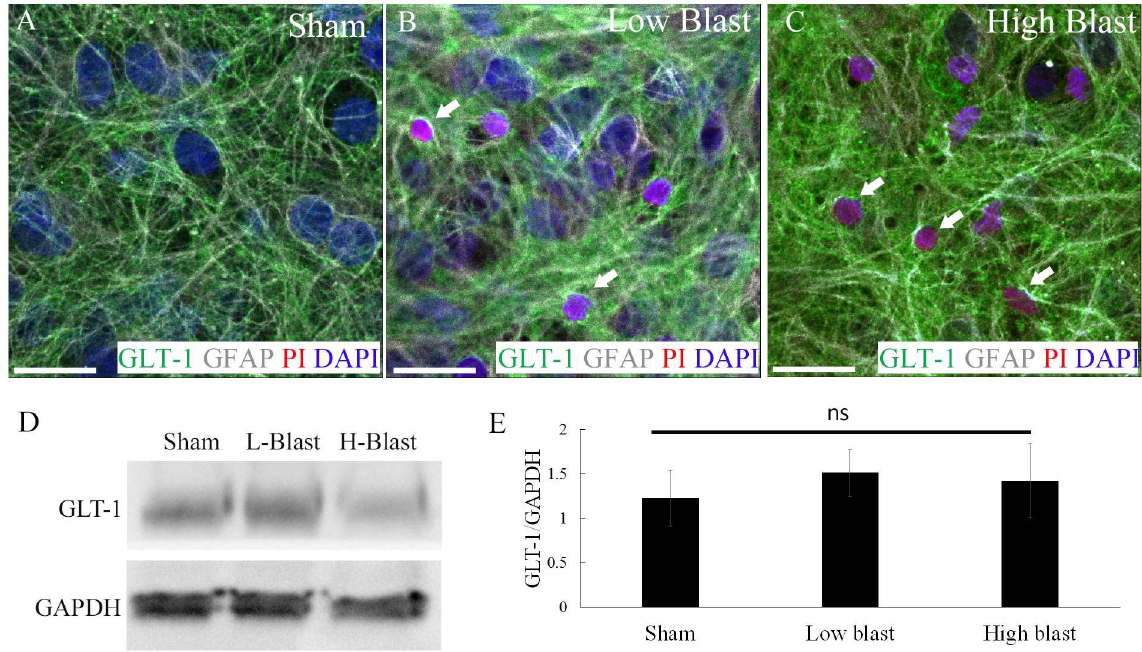
Fig 5. Blast-induced loss of GLT-1-expressing astrocytes. At 2 h followinginjury, sham control (A), low-blast(B), and high-blast (C) OHCs were stained using antibodiesagainstGLT-1 (green), GFAP (gray), PI (red), and DAPI (blue). Dead astrocytes, identified by co-labelingof GFAP and PI (arrows) were also positive for GLT-1. (D) Representative immunoblot analysesof GLT-1 protein expressionin sham control (Sham) and OHCs exposedto blast overpressure (L-Blast and H-Blast). (E) Densitometry analysisof GLT-1/GAPDH ratio for 3 independentexperiments revealed no significant(ns) differencesbetweensham control, low-blast,and high blast groups. Scale bars 20 μ m.